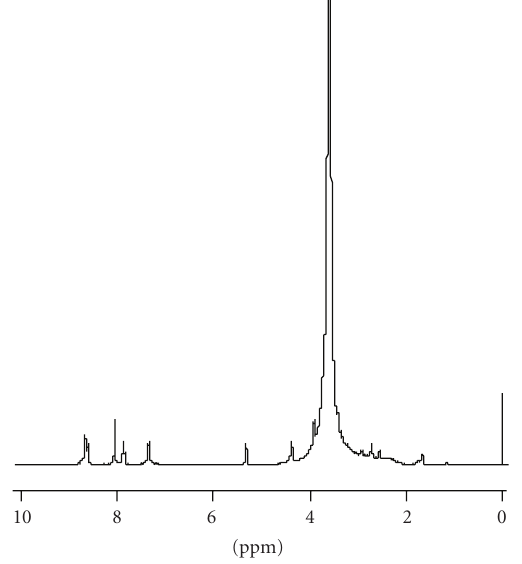
Figure 1: NMR spectrum of tpy-PEG-NH 2 . Solvent: chloroform-d, temperature: 20 ◦ C.